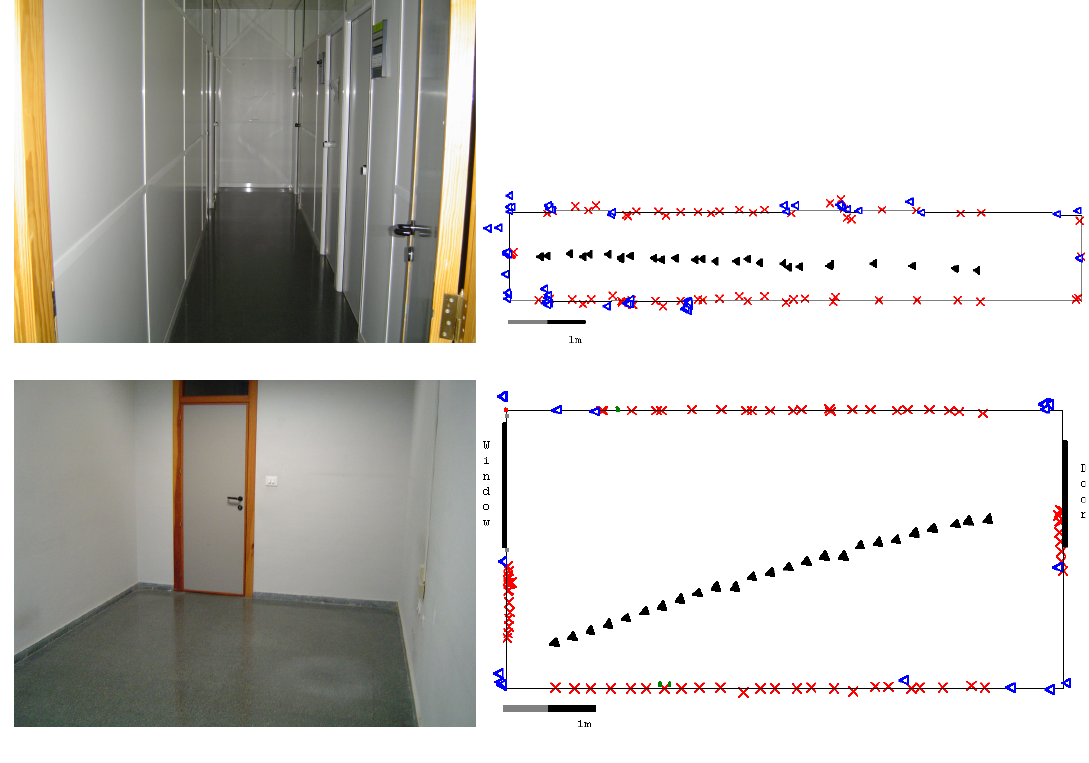
Figure 8. Examples of real environments where experiments were conducted. The resulting maps show the classified walls as red crosses, and the corners as blue triangles. The corresponding positions of the robot are represented as black filled triangles. Top left photo represents a small corridor. Note that the lateral walls have several door frames which are classified as corners in the corresponding map (top right). Down left photo shows an empty room. The corresponding map (down right) obtained shows the results of